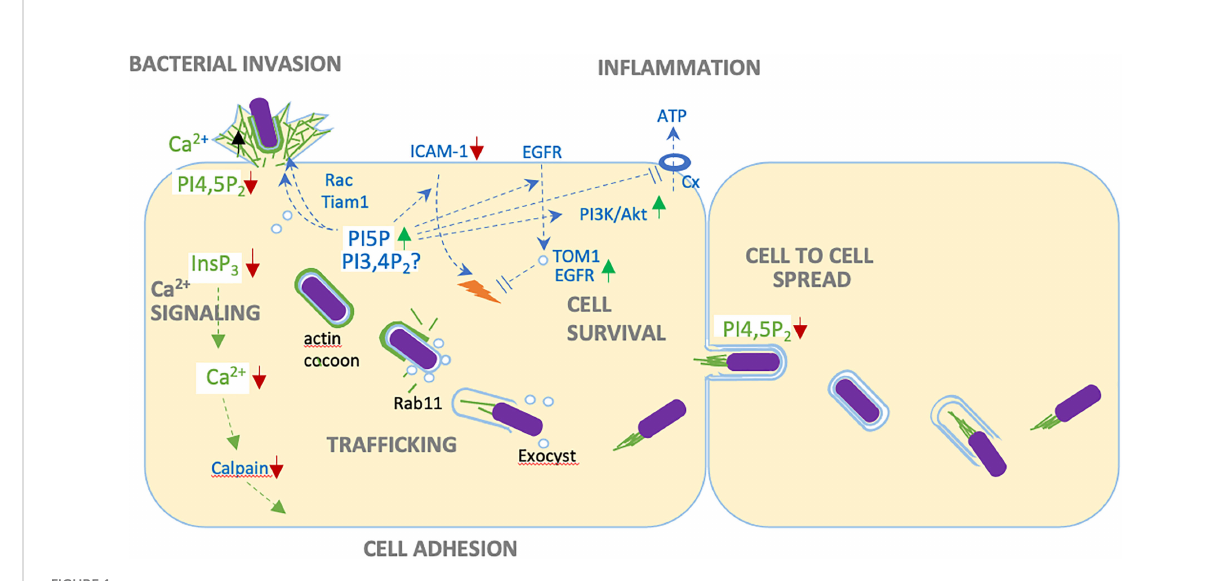
FIGURE 1 Versatile roles of IpgD during epithelial cell infection. Through PI4,5P 2 (PIP 2 ) hydrolysis, IpgD disconnect cortical actin from plasma membranes, favoring bacterial invasion and cell to cell spread. IpgD-mediated production of PI5P stimulates actin polymerization via Tiam-Rac activation, down-regulates the recruitment of immune cells by inducing ICAM-1 degradation, prevents the opening of connexin hemichannels, promotes persistent EGFR signaling by recruiting the TOM1 adaptor to endosome and preventing their maturation, and activates cell survival through the PI3K/Akt pathway. Possibly, these effects could also be linked to increased PI3,4P2 levels associated with the IpgD phosphotransferase activity. By decreasing InsP 3 levels, IpgD allows long lasting local Ca 2+ responses during invasion and prevents InsP 3 -dependent global Ca 2+ responses at later infection stages. Inhibition of Ca2+ signaling and calpain activity favors adhesion of infected cells. Through mechanisms the remain to be characterized, IpgD stimulates the formation of macropinosomes during bacterial invasion. IpgD also allows the recruitment of Rab11- positive endosomes and the exocyst, triggering bacterial unsheathing from the actin cocoon surrounding the BCV and vacuolar